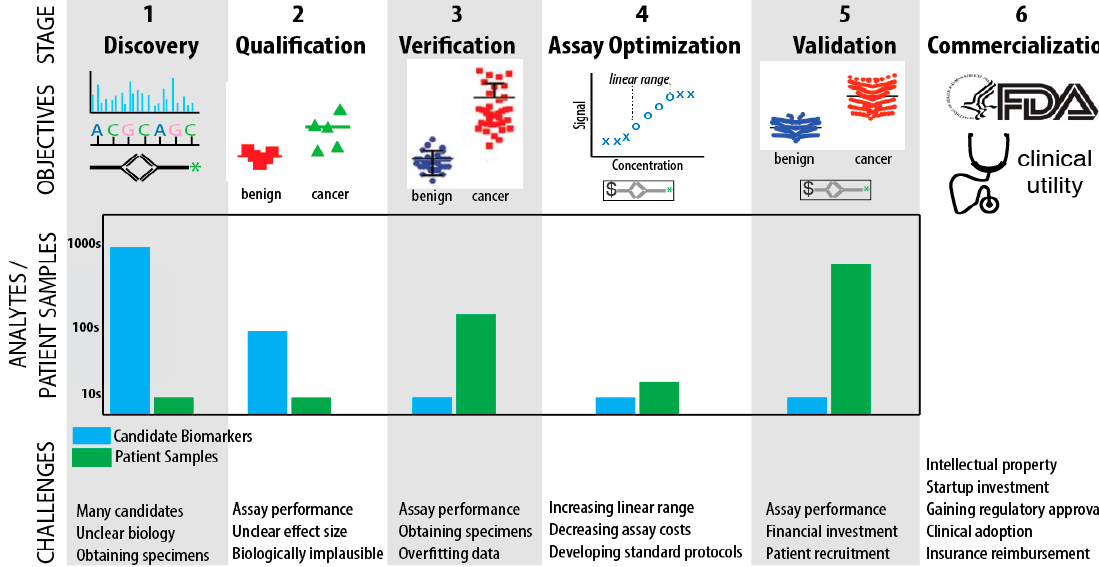
Figure 1. Illustration of the biomarker pipeline. Discovery of biomarkers typically utilizes mass spectrometry, nuclear acid sequence analysis, or ELISAs. In Qualification and Verification the objective is to find biomarkers or a panel of biomarkers that can separate cancer from benign disease and normal controls. During Assay Optimization the linear range of the assay is rigorously assessed and improved, if possible. There must be a representative diversity of patient samples chosen for Assay Optimization, so that the full spectrum of sample heterogeneity that may be ultimately encountered in the clinic is properly optimized for. For Validation, a prospective clinical trial is conducted and cost effectiveness is further assessed. Commercialization may proceed in concert with Validation and requires a demonstration of clinical utility. As the pipeline progresses, there is a sharp decrease in the number of biomarker candidates analyzed and a corresponding increase in the number of patient samples analyzed.